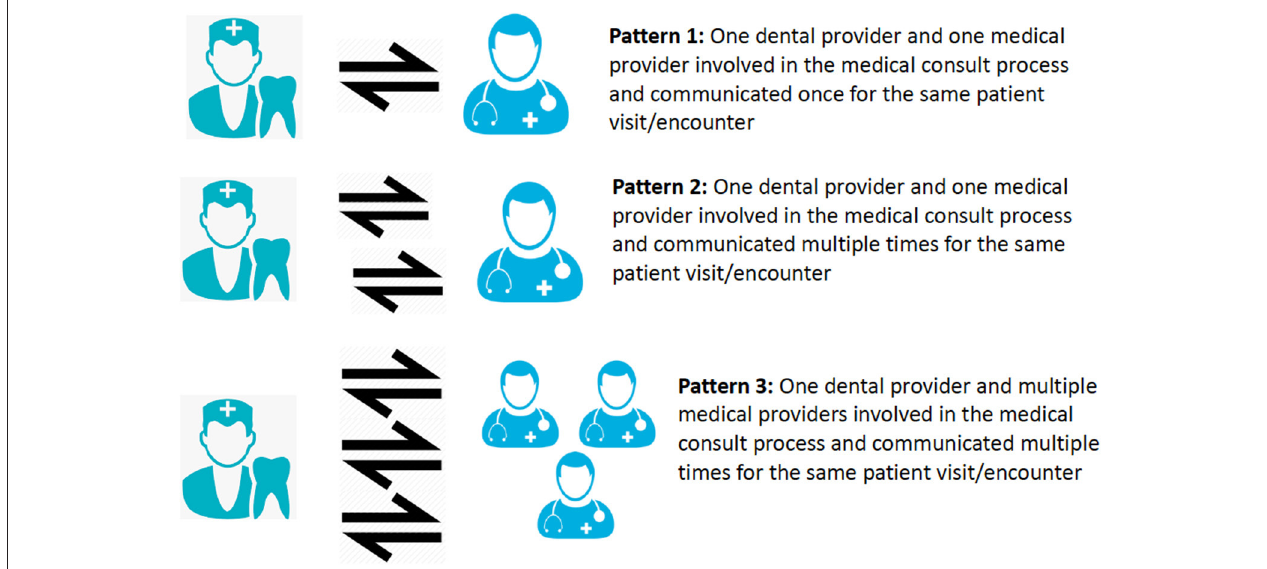
FIGURE 2 | Three communication patterns between dental and medical providers.